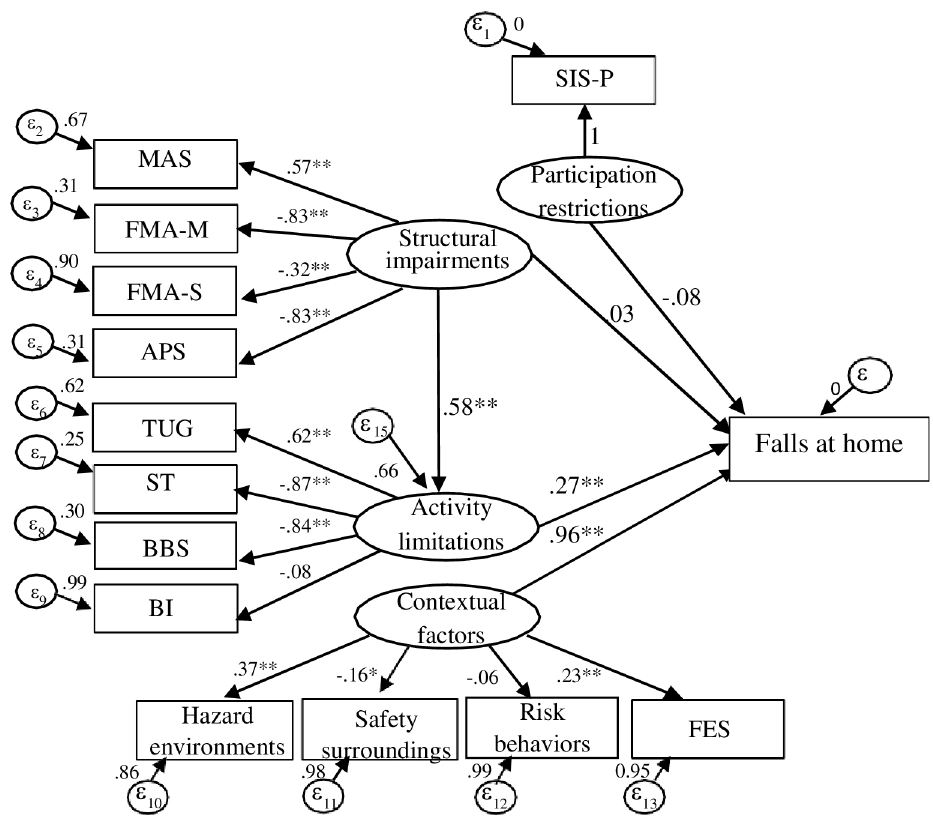
Fig 5. The structural model of falls at home in individuals with stroke. Value of factor loading and amount of measurement error are shown. The inter-relationships of residual variables are not shown. � p < 0.05, �� p < 0.001. MAS: modified Ashworth scale; FMA-M: Fugl-Meyer Assessment upper and lower extremity function; FMA-S: Fugl- Meyer Assessment sensory function; APS: Ankle plantarflexor strength; TUG: Timed Up and Go Test; ST: Step Test; BBS: Berg Balance Scale; BI: Barthel Index; SIS-P: Stroke Impact Scale-participation/role function; FES: Fall-related Self Efficacy; ε n: residual variable.